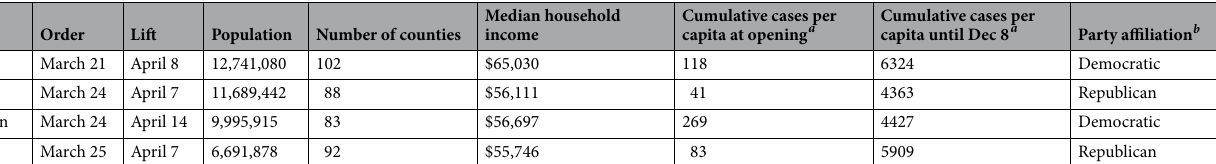
Table 1. The sociodemographic and economic characteristics of Illinois (IL), Ohio (OH), Michigan (M) and a Indiana (IN). Cumulative cases per 100,000 population